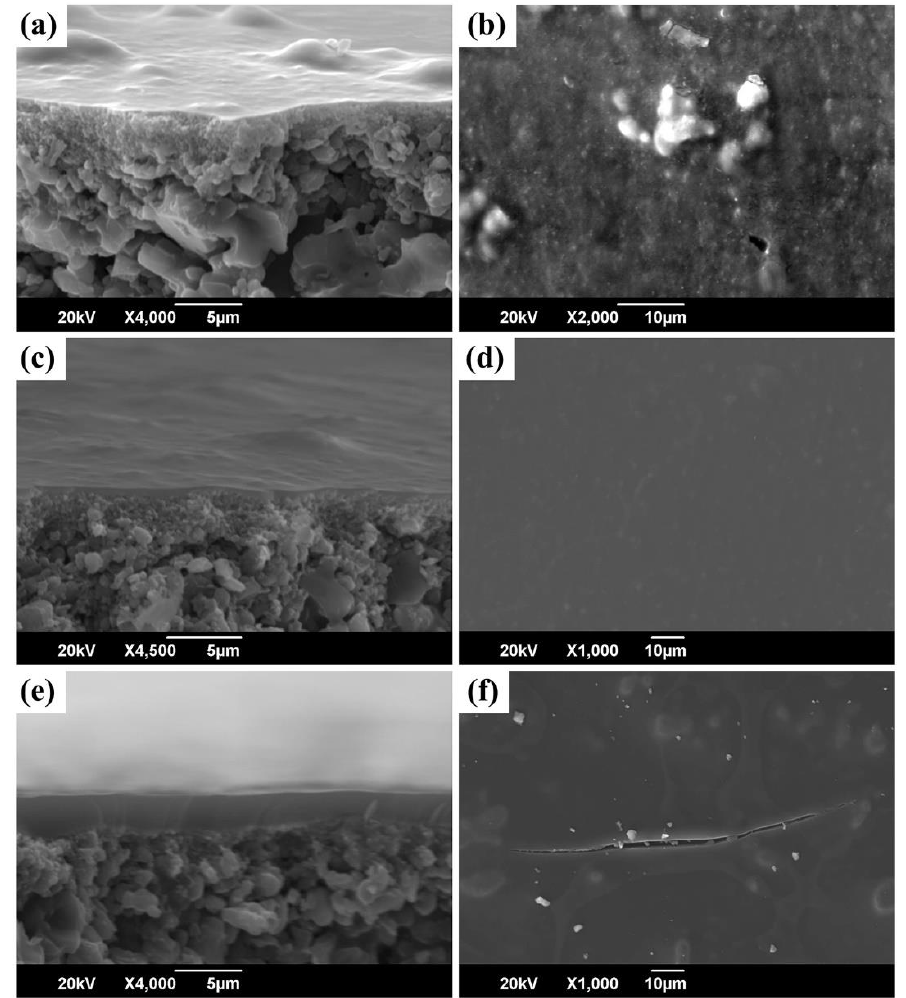
Figure 9. Scanning electron microscopy (SEM) images of cross-sections and surfaces of SiC mem- branes obtained from different concentrations of coating solutions: ( a , b ) 1 wt%; ( c , d ) 3 wt%; and ( e , f ) 5 wt%. Reprinted from [82] with permission from John Wiley and Sons.